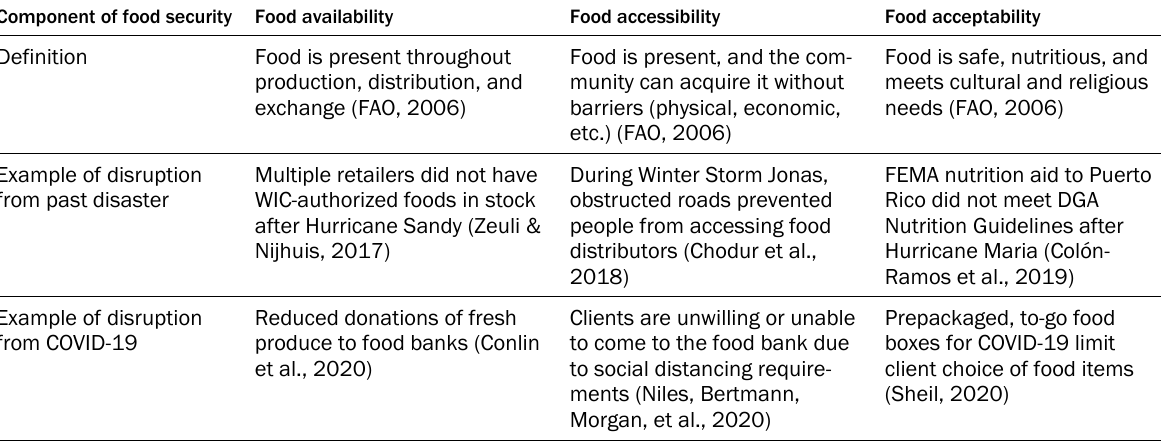
Table 1. The Three Components of Food Security (Food Availability, Accessibility, and Acceptability) with Examples of Disruptions Due to Past Disasters and the Ongoing COVID-19 Pandemic Component of food security Food